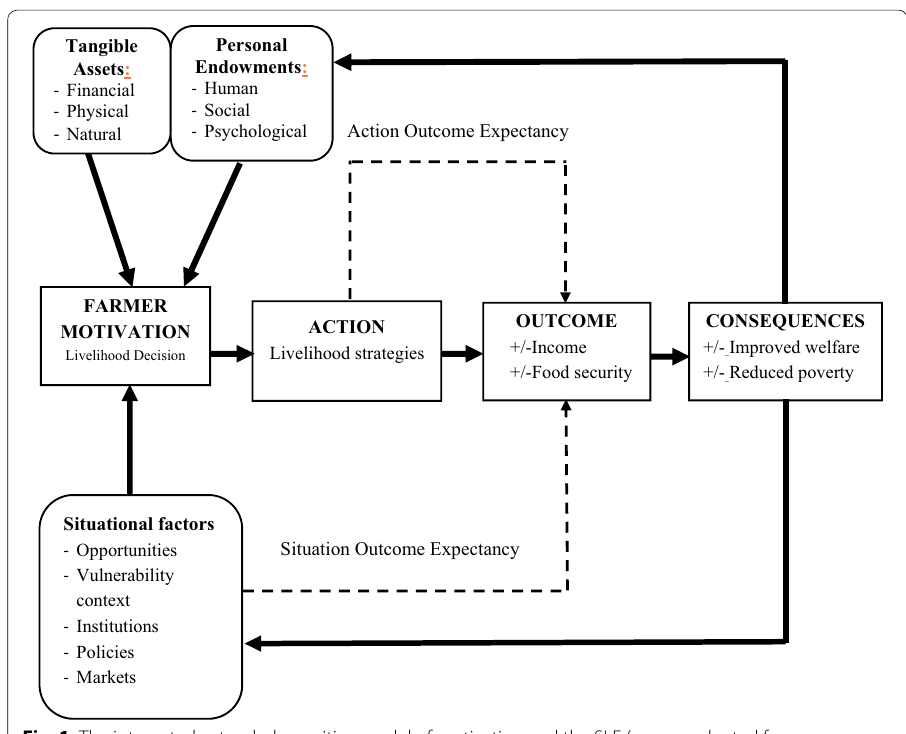
Fig. 1 The integrated extended cognitive model of motivation and the SLF (source: adapted from Heckhausen and Rheinberg (1980), DFID (1999) and Chipfupa and Wale